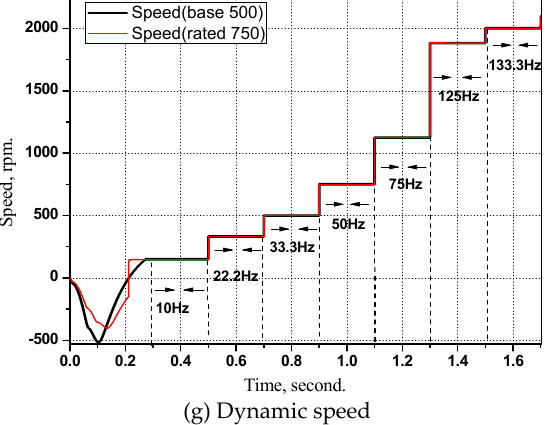
Figure 19. Simulation results at the base and rated speed operating patterns. ( a , b ) Dynamic results as compared by steady-state characteristics. ( c – g ) Dynamic characteristics at CT up to base speed (proposed) as compared by CT up to rated speed (conventional).